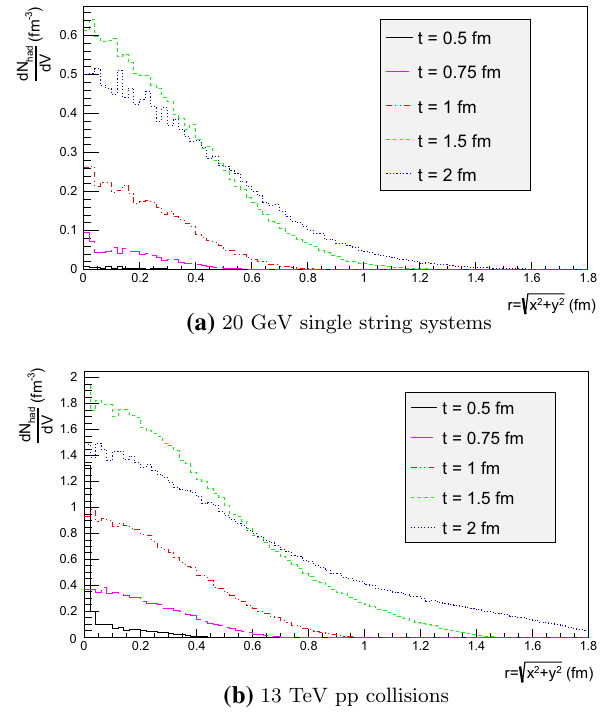
Fig. 22 Hadronic density as a function of the radius for different con- stant times, for a central slice | z | < 0 . 5 fm